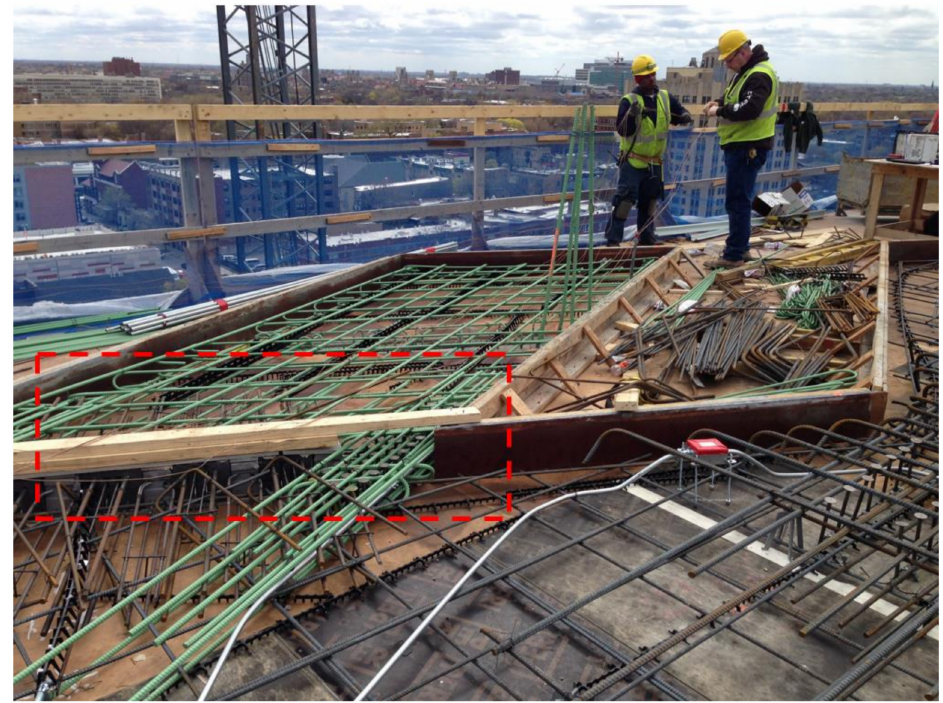
Figure 2. Balcony thermal break product and on-site